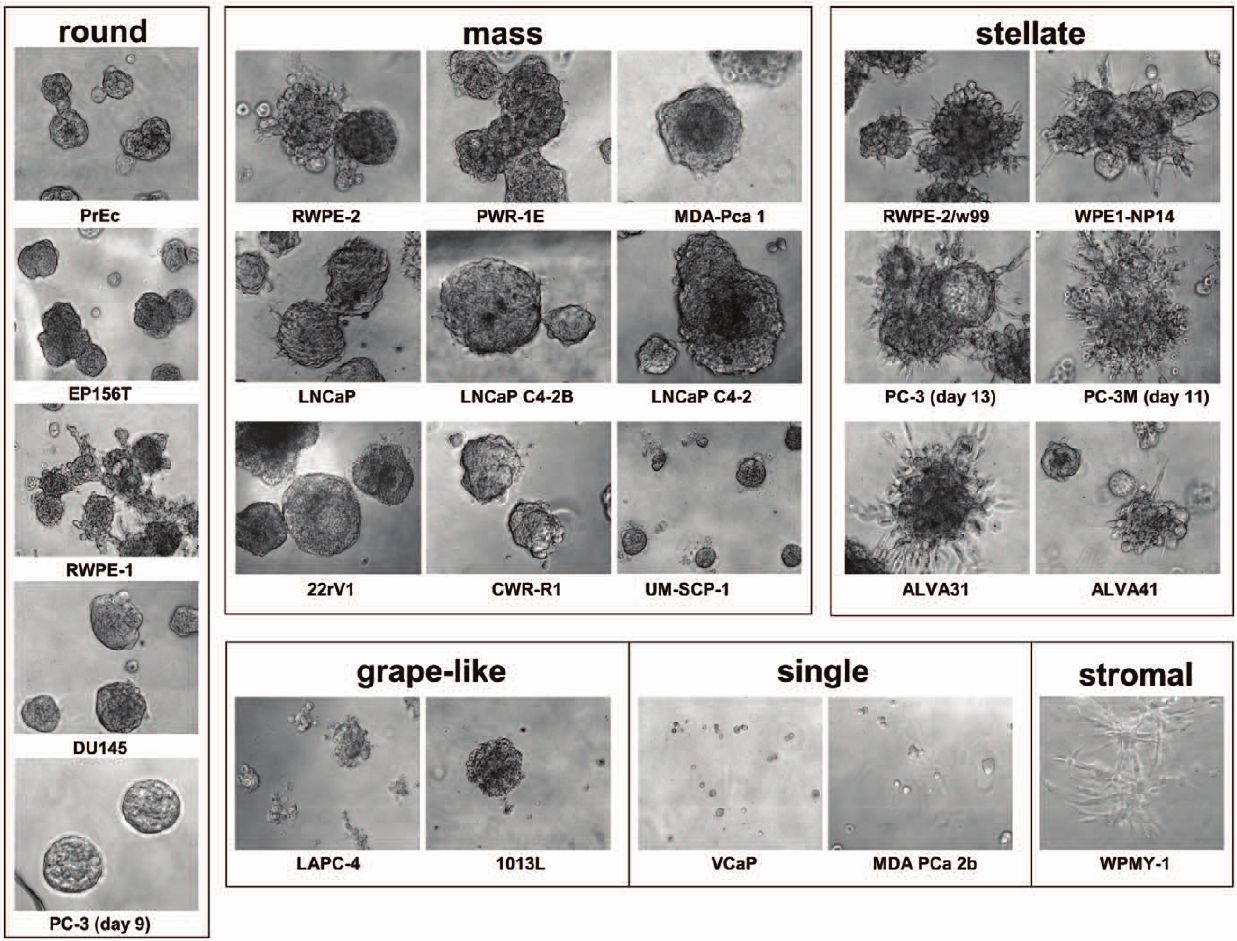
Figure 1. Representative phase contrast images of spheroids formed in 3D Matrigel culture. Most structures fell into the categories round, mass, stellate, or grape-like. Some cell lines failed to form spheroids in Matrigel but persisted as single live cells for up to two weeks (single phenotype). Most spheroids were imaged at days 9–10 after inoculation. PC-3 spheroids, shown as round phenotype at day 9, undergo a metamorphosis to invasive/stellate phenotype at day 13. The same occurs to PC-3M at an earlier time point (day